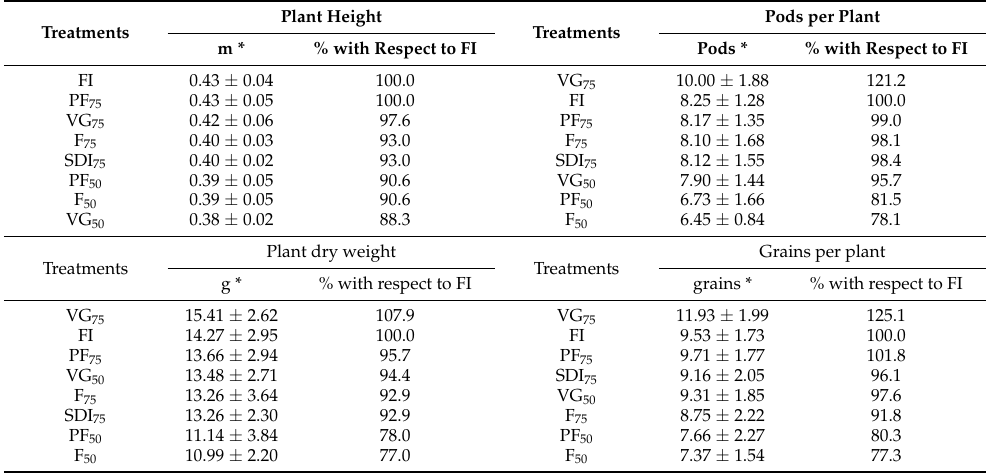
Table 7. Differences (%) in plant height (H), plant dry weight (PDW), pods per plant (PP), and grains per plant (GP) among irrigation